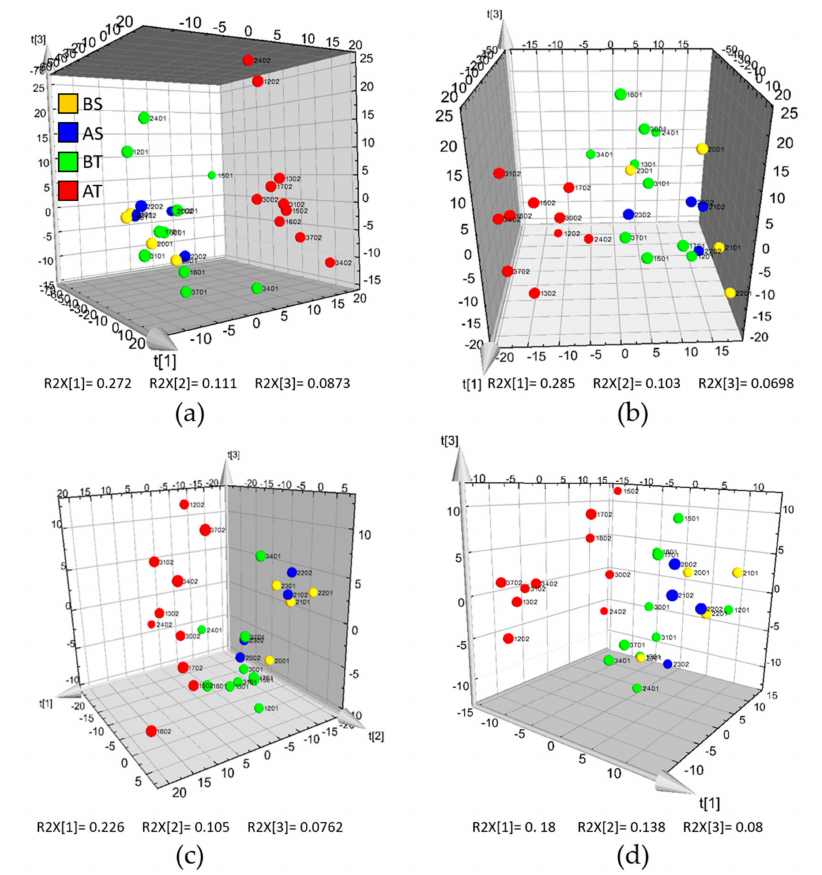
Figure 4. 3D PCA score plots of the hydrophilic interaction (HILIC) and reverse phase (RP) LC-MS datasets: ( a ) HILIC LC-MS in positive ionization mode; ( b ) HILIC LC-MS in negative ionization mode; ( c ) RP LC-MS in positive ionization mode; and ( d ) RP LC-MS in negative ionization mode. Samples from pigs before and after the sham procedure are colored yellow (BS) and blue (AS), while those before and after trauma injury are red (BT) and green (AT), respectively. For the sample IDs, the first two digits denote the pig ID, followed by the time point at which the blood was drawn: (01)—before trauma / sham and (02)—after trauma /